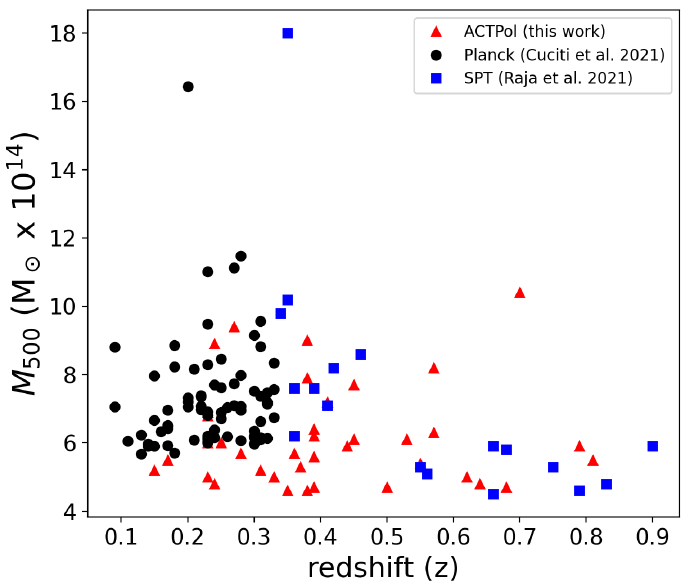
Figure 2. The ACTPol sample in comparison to the Planck sample [25] and SPT [55] sample used for statistical studies of diffuse